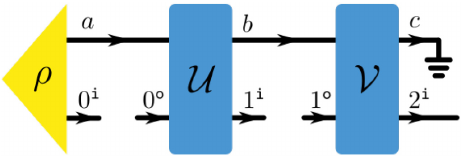
FIG. 30. Three-step process. Graphic provided as reference for the considerations of Sec. VI B 1.